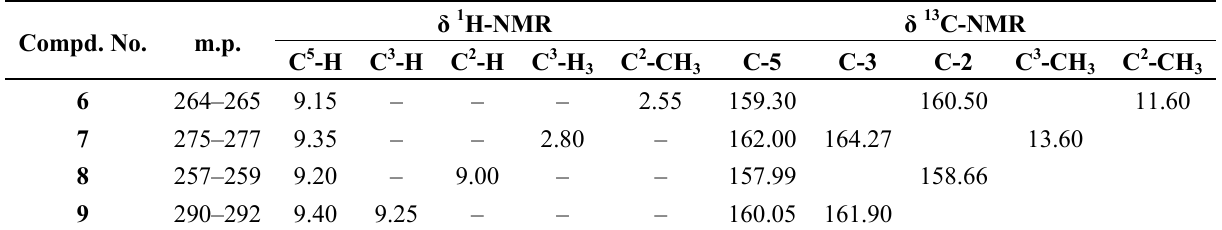
Table 1. M.p., 1 H- and 13 C-NMR values of triazole and pyrimidine protons of compounds 6 – 9 . Compd.